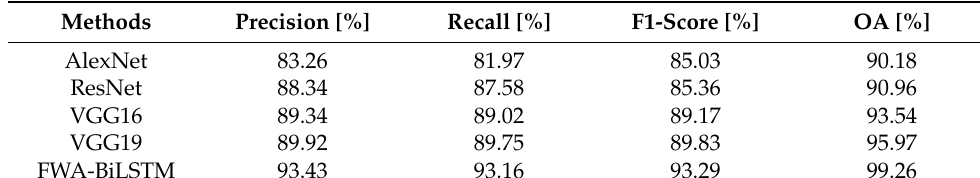
Table 4. Performance of deep learning model on LEVIR-CD dataset.